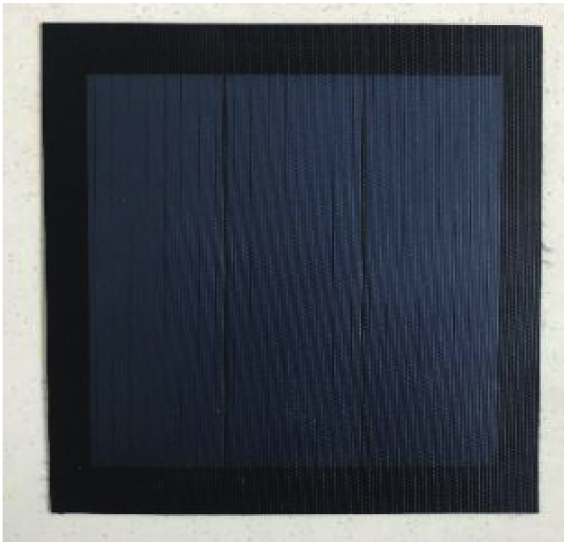
Figure 3: Finished battery